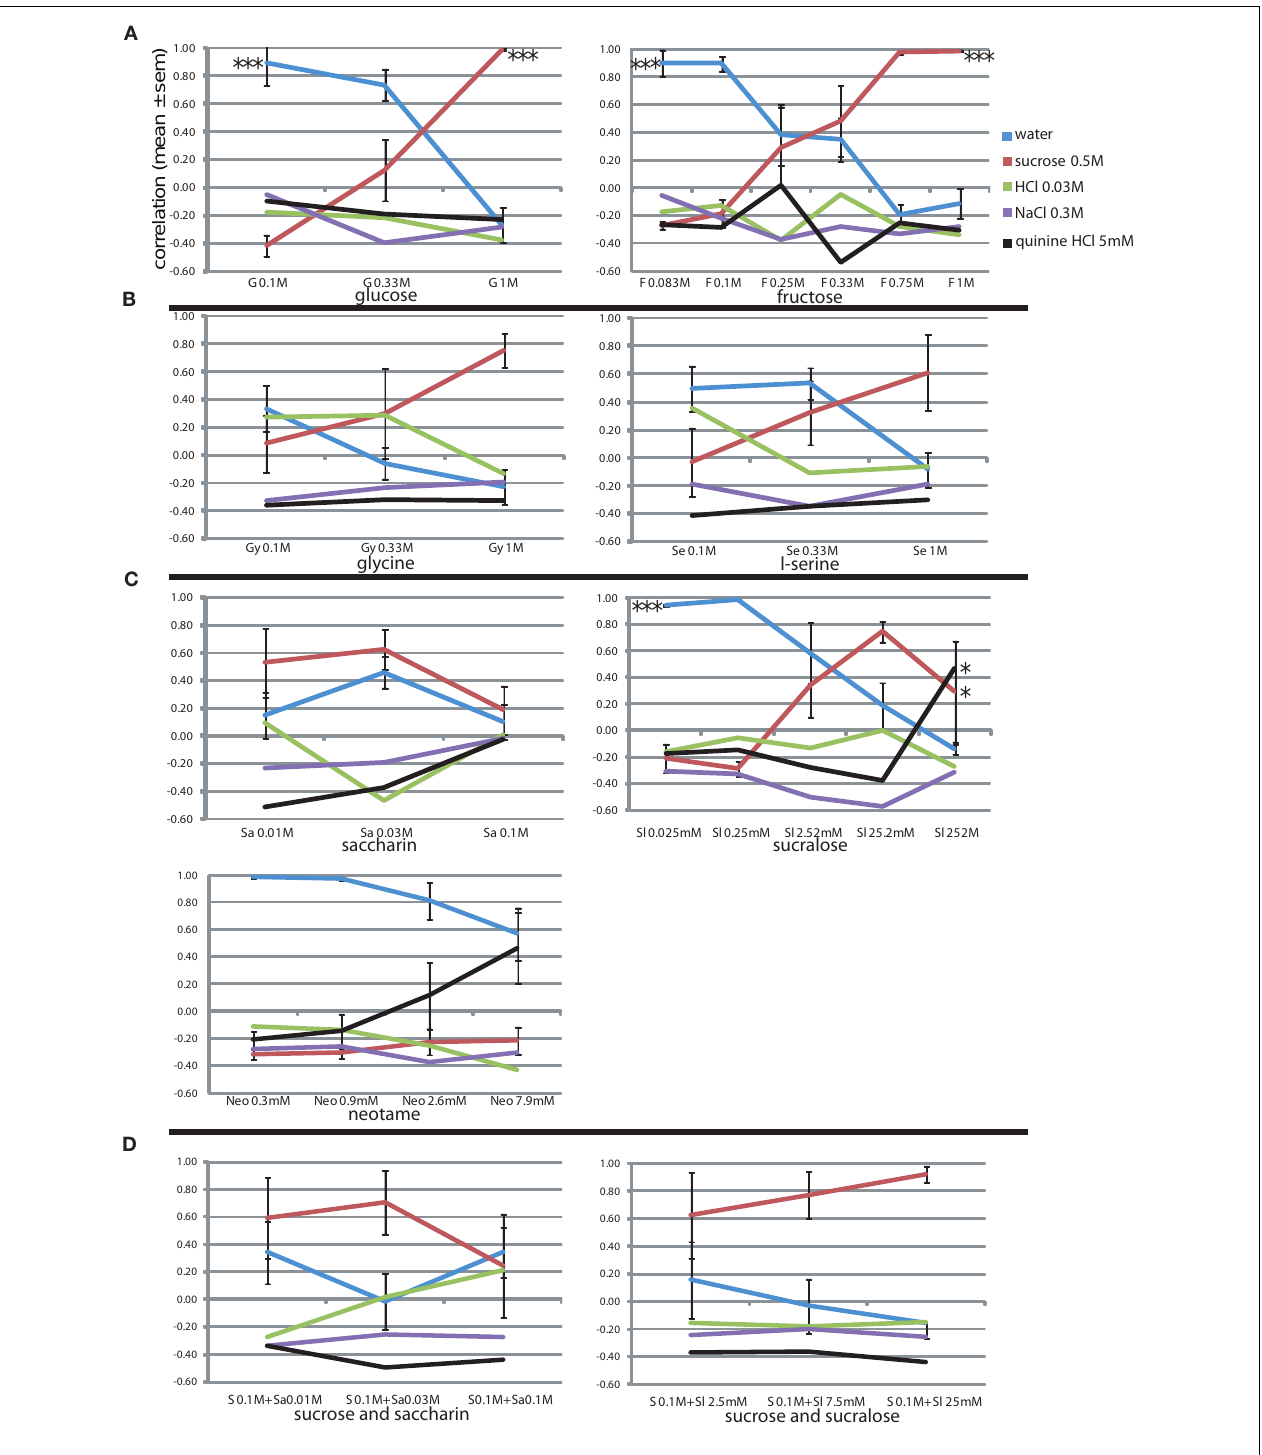
FIGURE 4 | Concentration–response generalization curves of sweet tastants. * P < 0.05, ** P < 0.01, *** P < 0.001 (MANOVA on concentration). (A) Sugars. (B) Amino acids. (C) Artificial sweeteners. (D) Sucrose